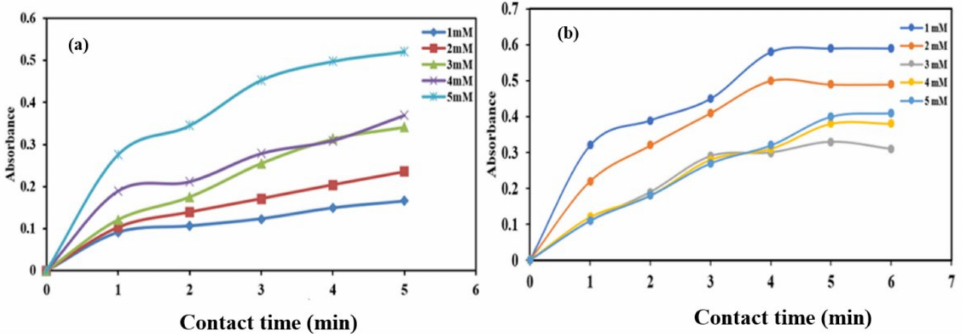
Figure 6. ( a ) Plot of change absorbance vs. time for various doses of nanocomposite using ( a ) catechol ( b ) resorcinol (pH = 3.0 at 25 ◦ C, and 0.5 mL H 2 O 2 ).